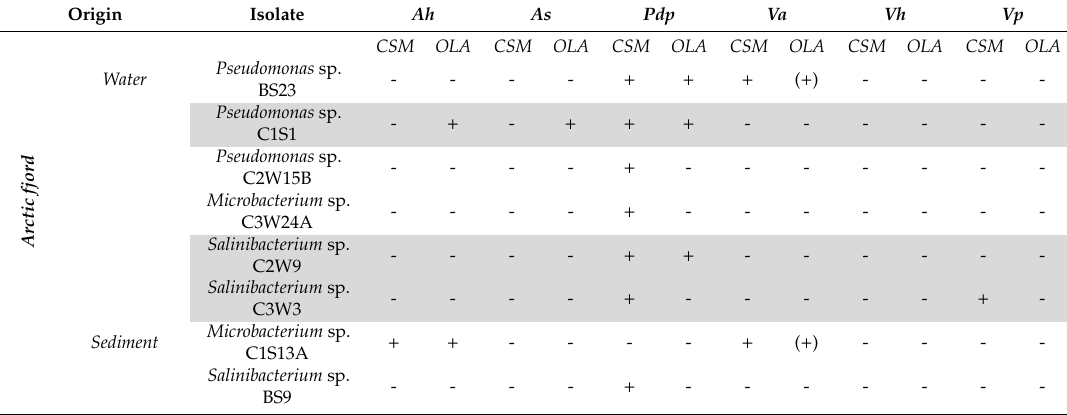
Table 2. Pre-screened isolates from Arctic fjord and Mediterranean Sea environments against pathogens relevant in aquaculture. Isolates in grey boxes were selected for further analyses. + , activity; ( + ) weak activity; - no